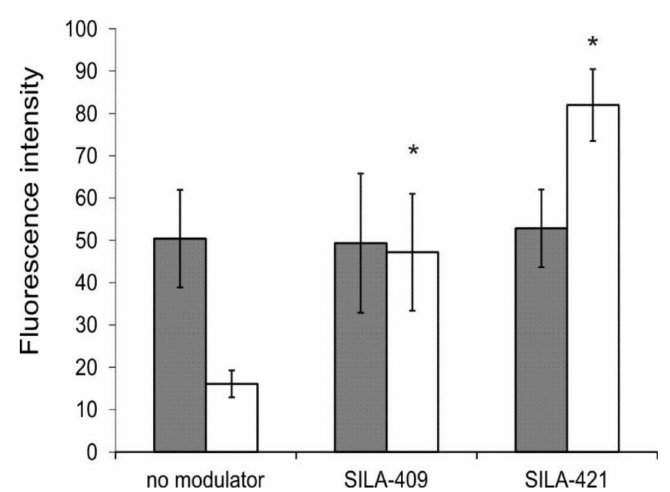
Figure 5. Intensity of intracellular fluorescence of Dox, measured by ImageJ software, in LoVo (gray bars) and LoVo / Dx cells (white bars) treated with 5 µ M of SILA-409 and SILA-421 is presented